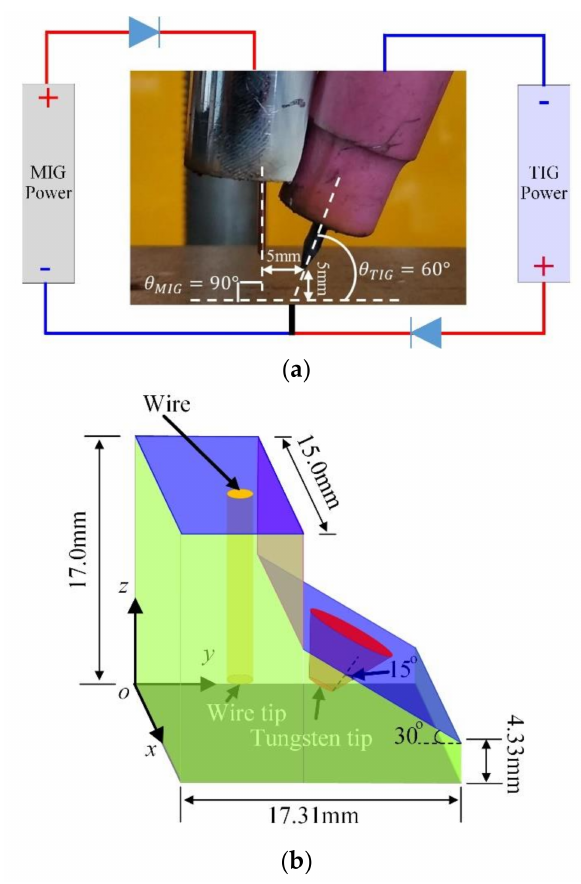
Figure 1. Schematic diagrams of the tungsten inert gas-metal inert gas hybrid welding (TIG-MIG) system. ( a ) Spatial positions of TIG and MIG torches in the experimental system. ( b ) Simplified calculation